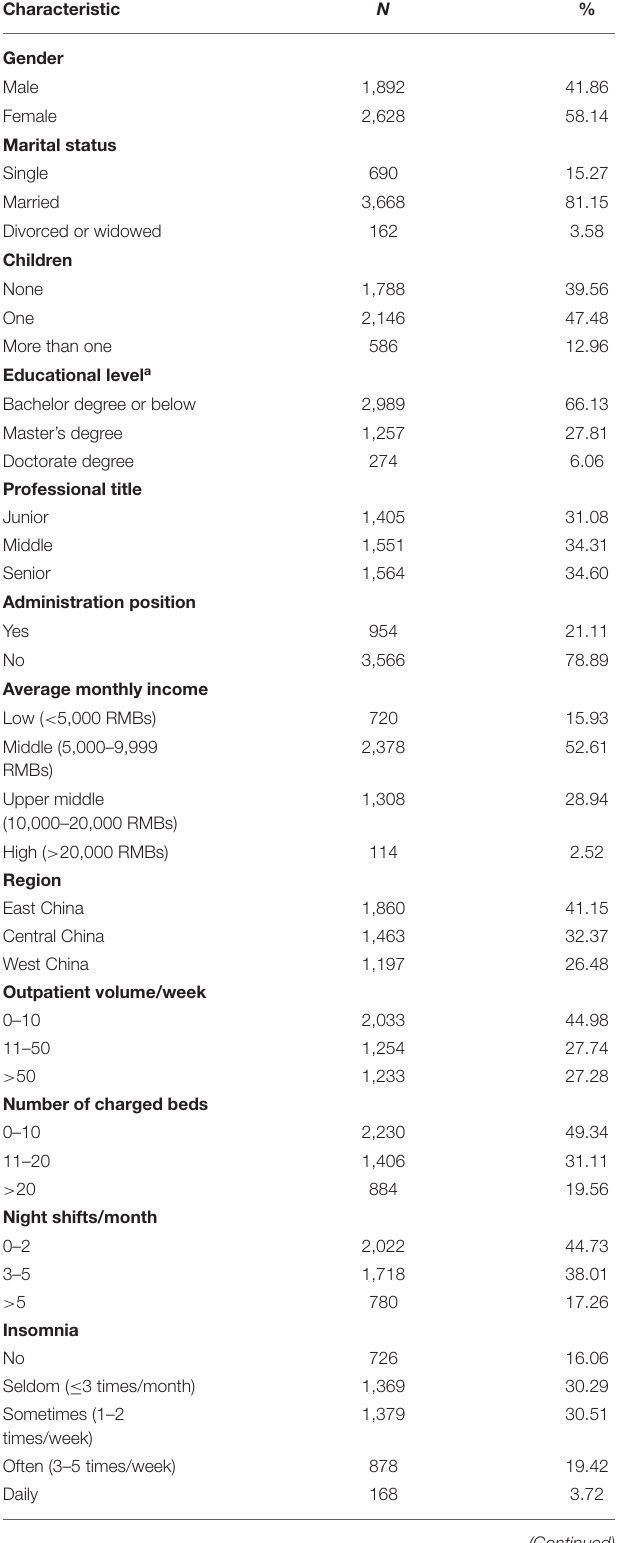
TABLE 1 | Characteristics of physicians in Chinese tertiary psychiatric hospitals ( N =